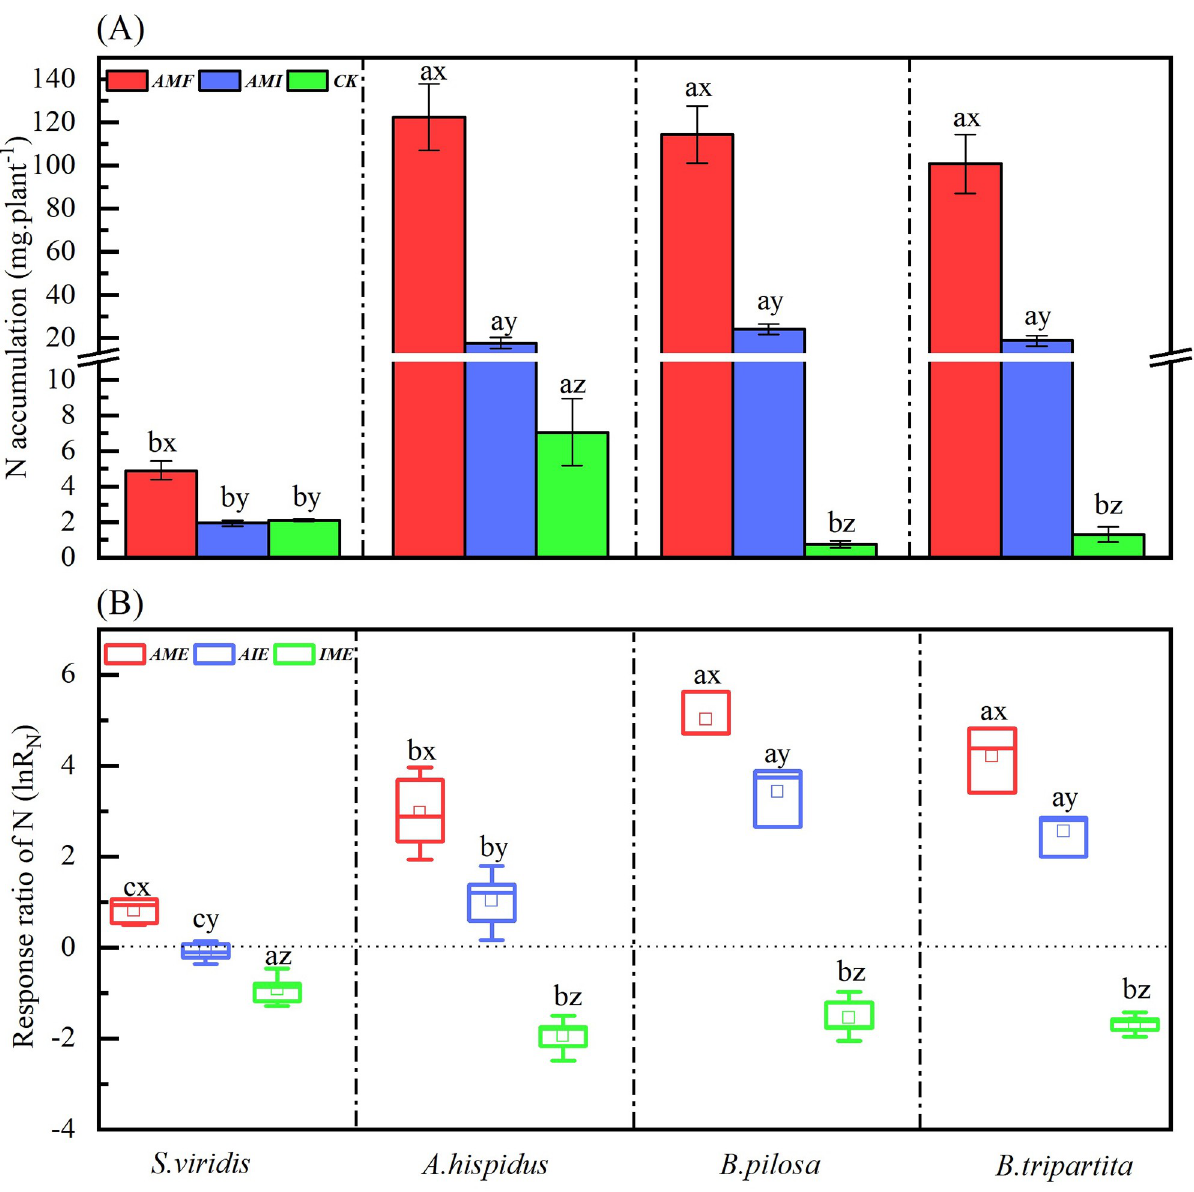
Fig 2. N accumulation (A) and response ratio lnR N (B) of four plant species through the different microbial treatments. The meanings of abbreviations ( S . v , A . h , B . p and B . t ; AMF , AMI , and CK ; AME , AIE and I ME ) and the lowercase letters (a, b, c, d; x, y, z) are the same as in Fig 1.